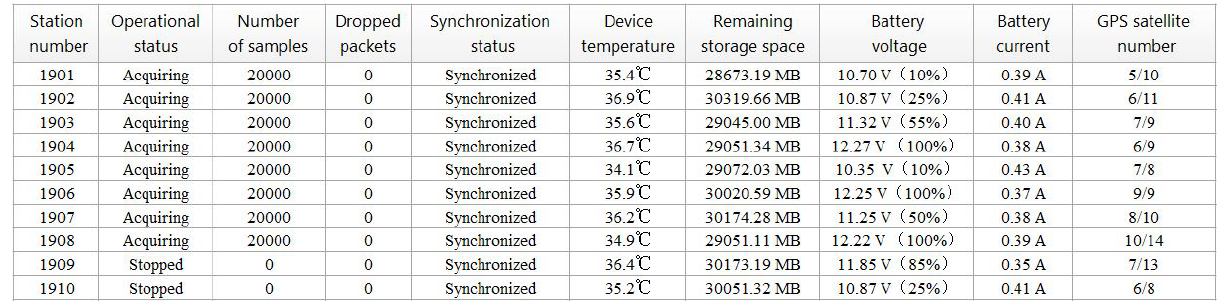
Figure 11. A screenshot of the status data reported by each data acquisition